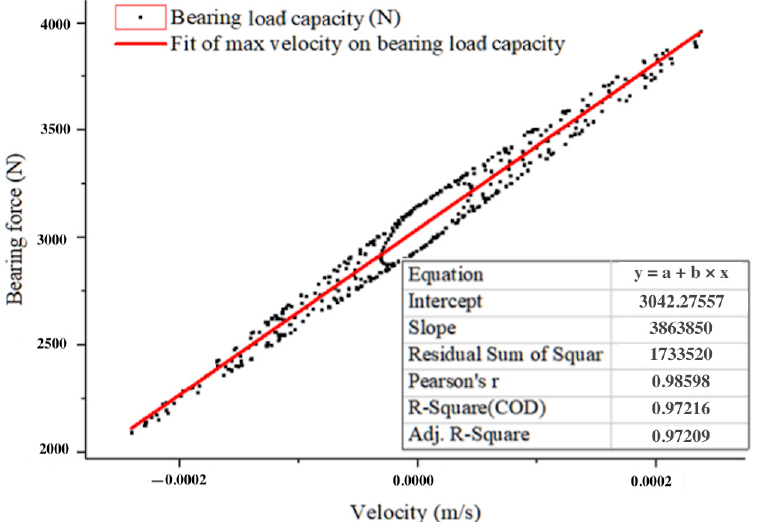
Figure 10. Linear fitting of the supporting load capacity with maximum film surface